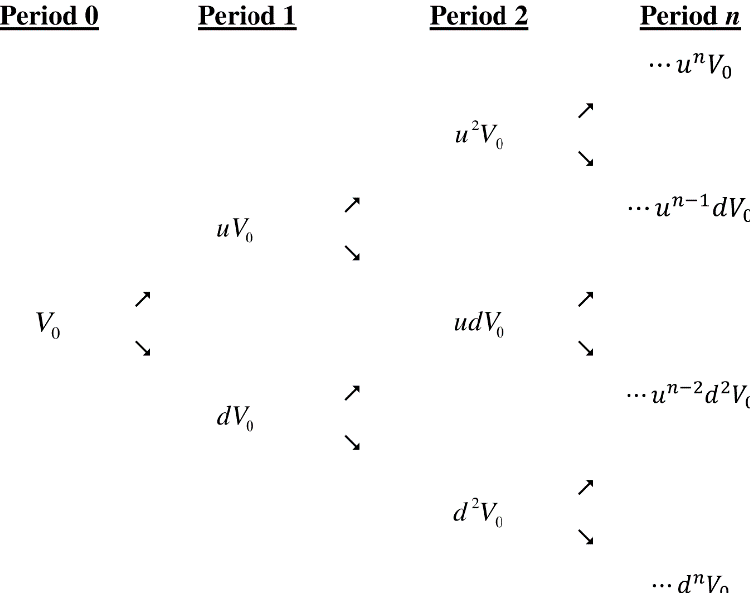
Figure 2. Evolution of the project value in n periods following the binomial model (source: own